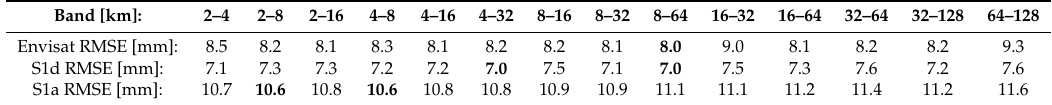
Table 3. Root mean square errors for different power-law filtering bands. The best results are highlighted in bold. The area of main deformation (cf. Figure1) is excluded from this